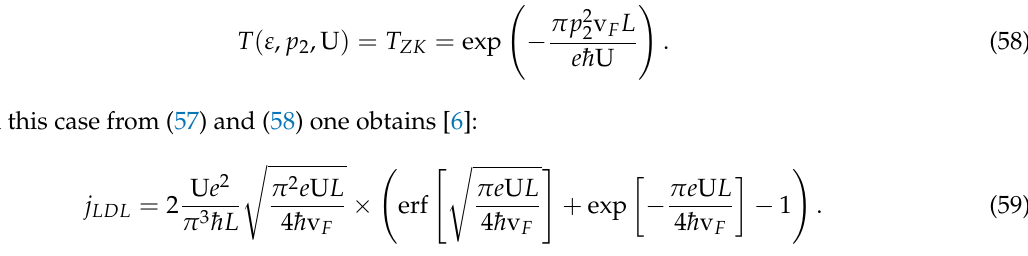
0.0018 for different −